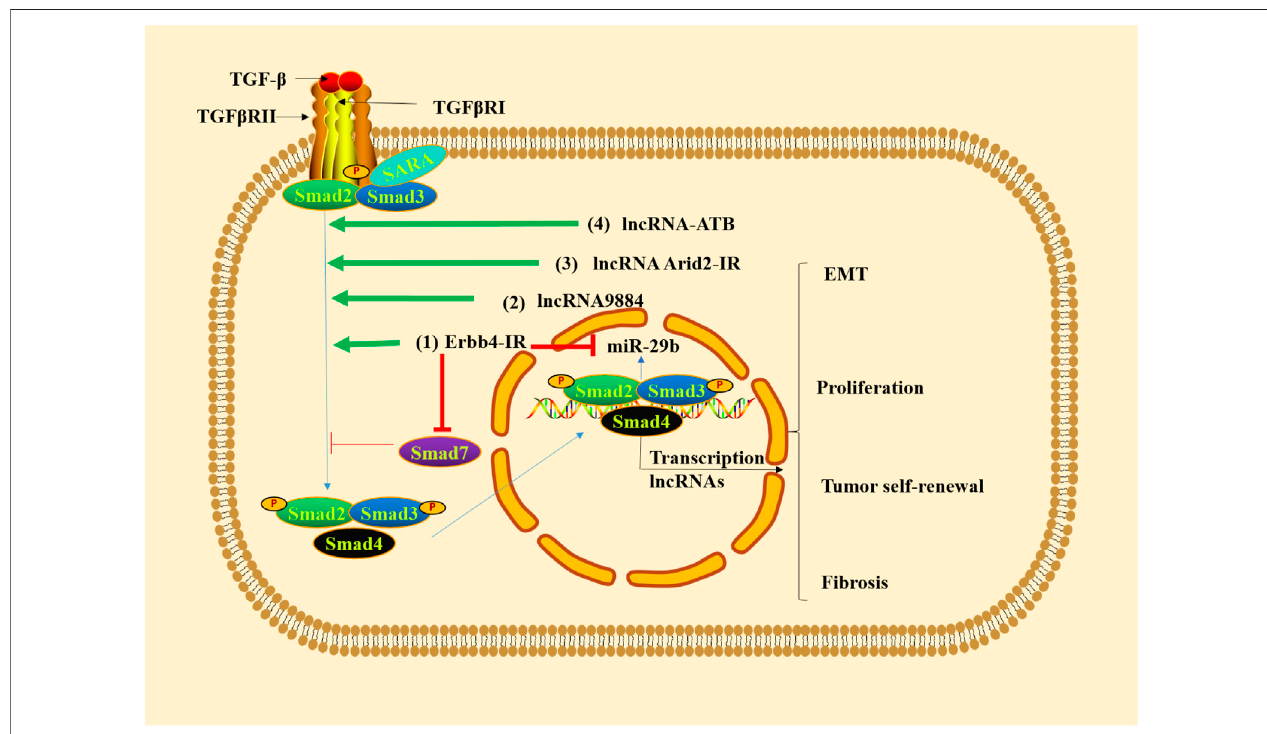
FIGURE 2 | TGF- β 1/Smad3 signaling regulates lncRNAs in renal fi brosis. (1) Erbb4-IR promotes renal fi brosis by suppressing miR-29b and downregulating Smad7. (2) lncRNA9884 is signi fi cantly upregulated in renal fi brosis. (3) The increased lncRNA Arid2-IR leads to ECM production in renal fi brosis. (4) lncRNA-ATB activates TGF- β /Smad2/3 pathway, thus promoting in fl ammation, cell apoptosis and senescence.